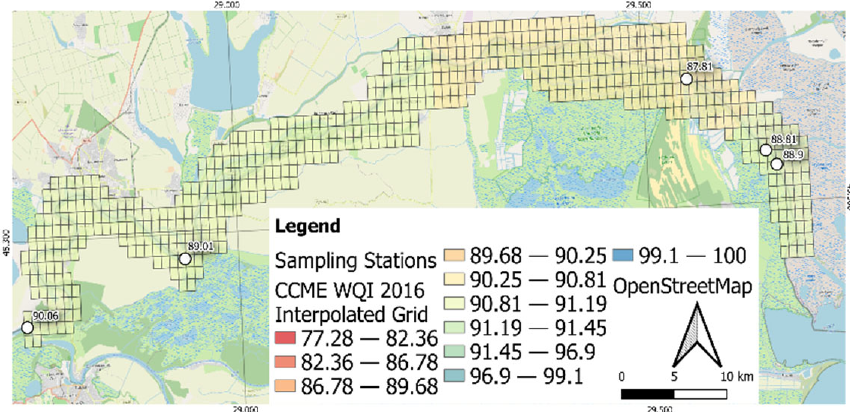
Figure 6. CCME WQI trends in 2015 on the Chilia branch.